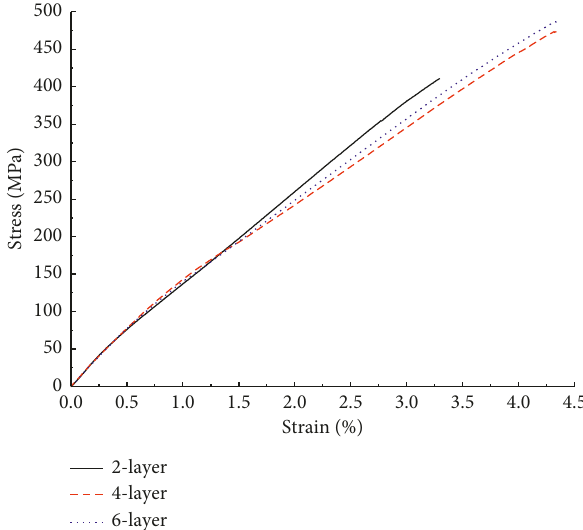
Figure 2: Effect of the number of layers on stress-strain re- lationship of BFRP-CFRC